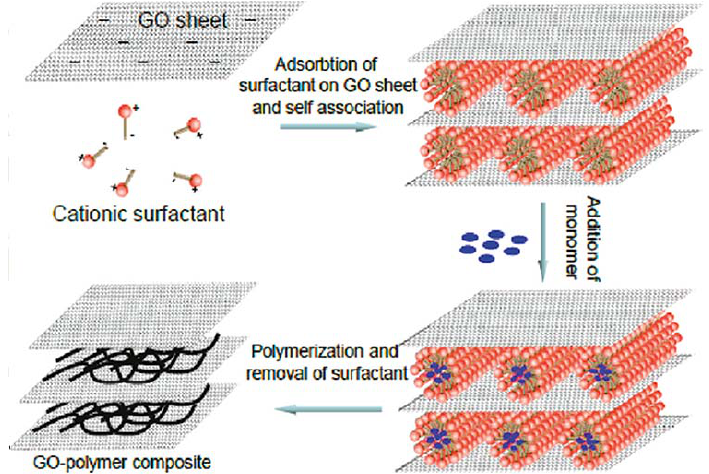
Figure 12. Schematic illustration of the formation process of the sandwich-structured GO/PPy composites. Reprinted with permission from [38]. Copyright 2010 American Chemical